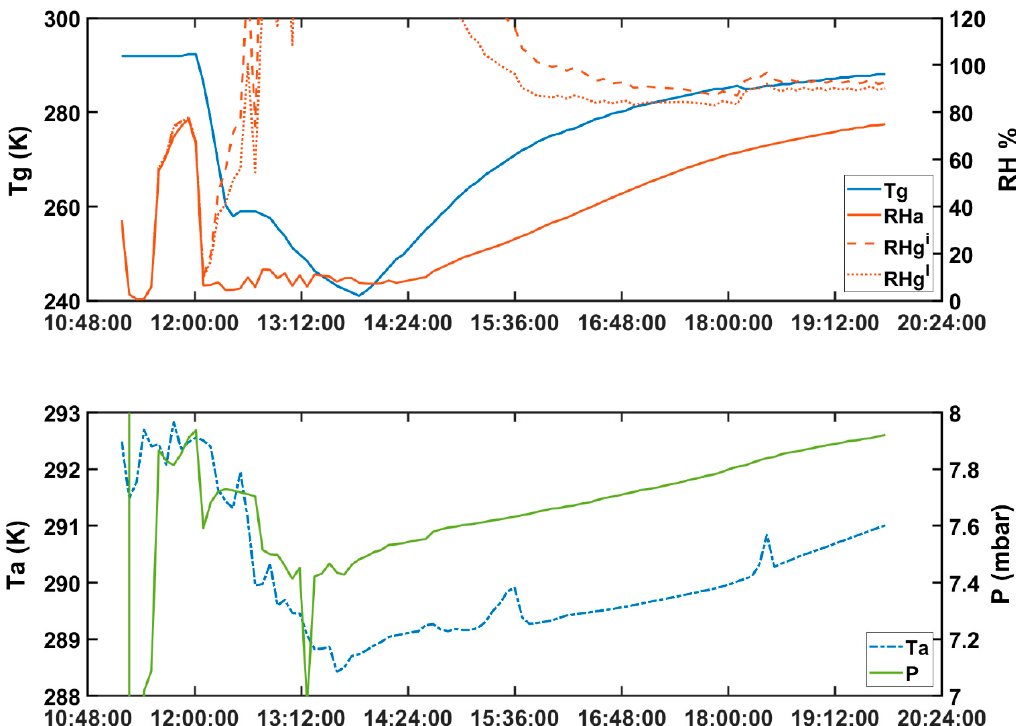
Figure 4. Example of the time evolution of some of the environmental parameters inside the chamber when simulating the transition from a Martian night to a Martian day. For this specific configuration, the ground relative humidity is saturated and allows for frost formation, when the ground temperature is under 260 K.